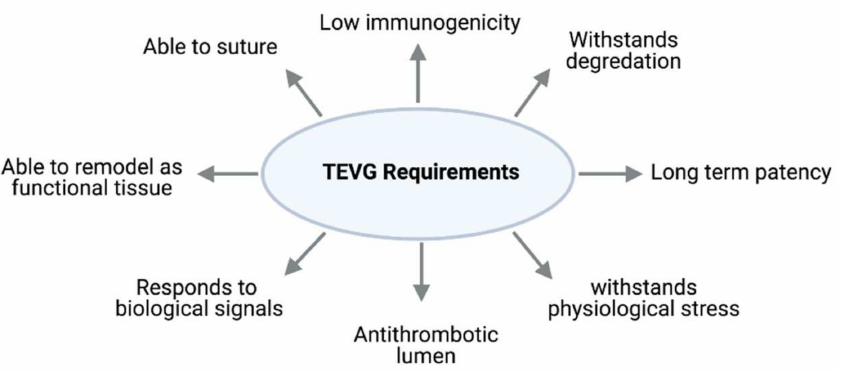
Figure 3. Key factors to be considered for an ideal